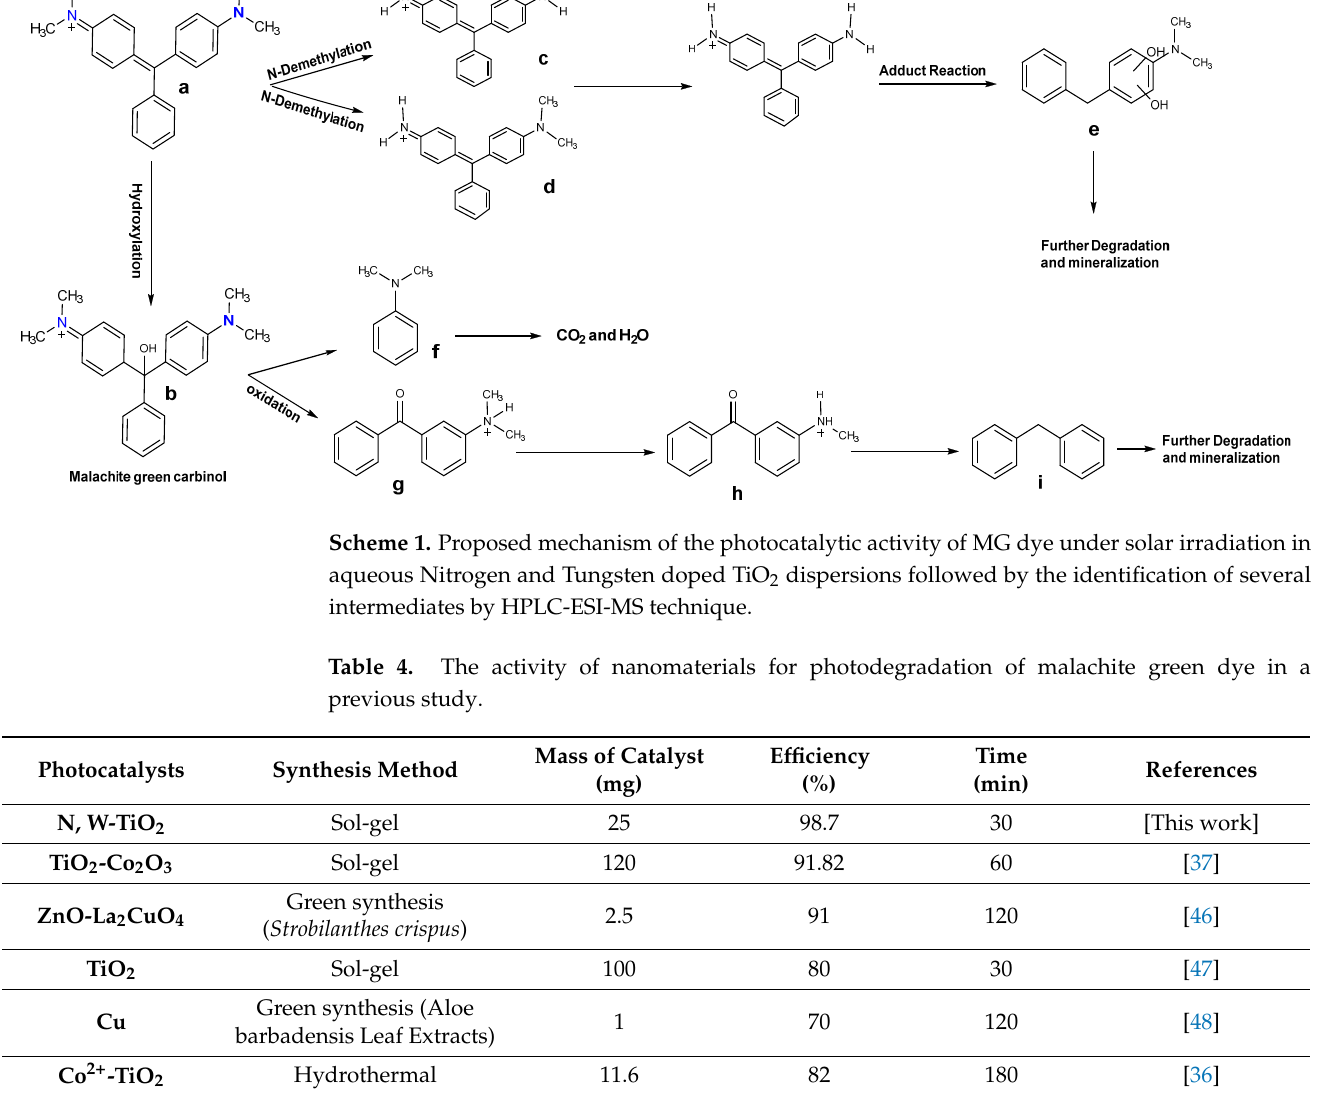
Table 4. The activity of nanomaterials for photodegradation of malachite green dye in a previous study.